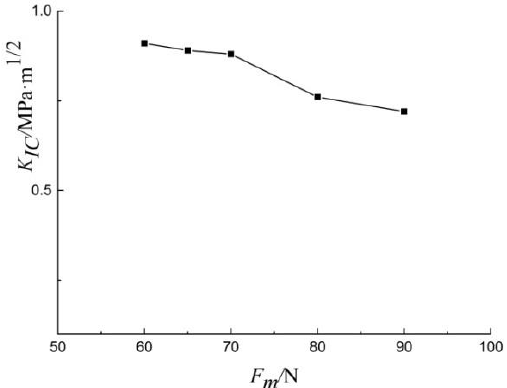
Figure 12. K IC versus F m generated with the Berkovich indenter.